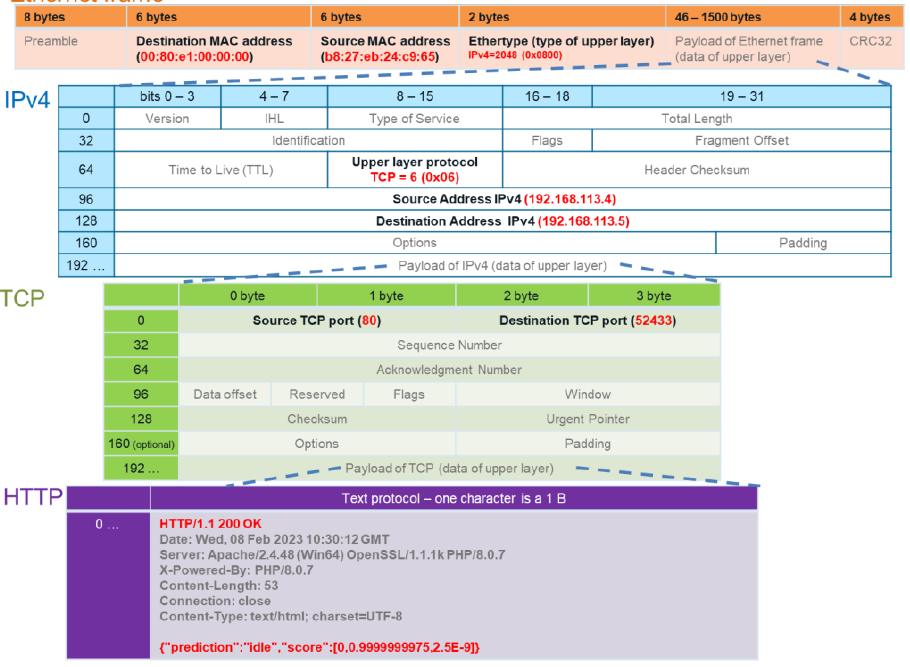
Figure 6. Response from the fault prediction server with HTTP/1.1 encapsulated in the lower layers of the OSI-ISO